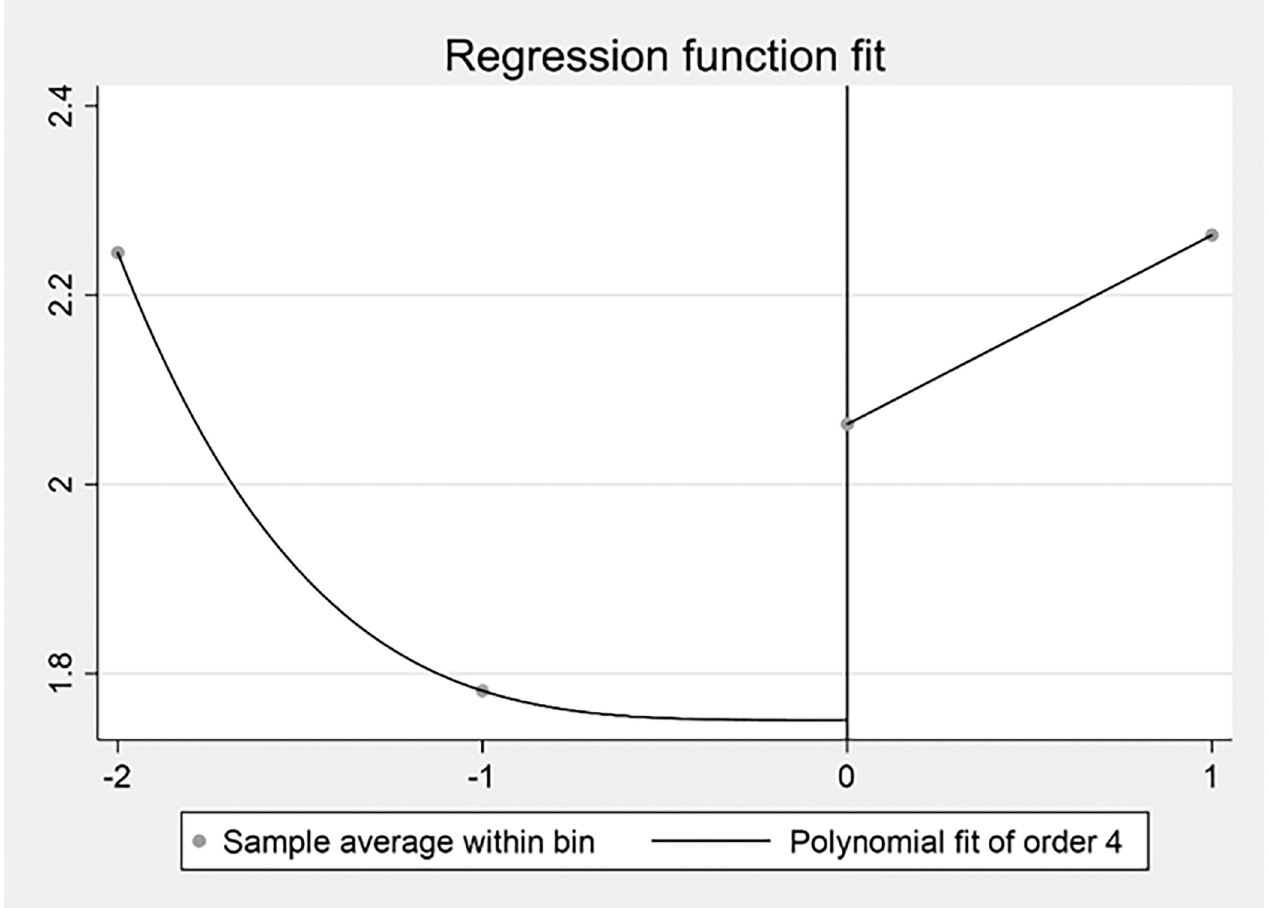
Fig 9. The COVID-19 pandemic and firm performance.